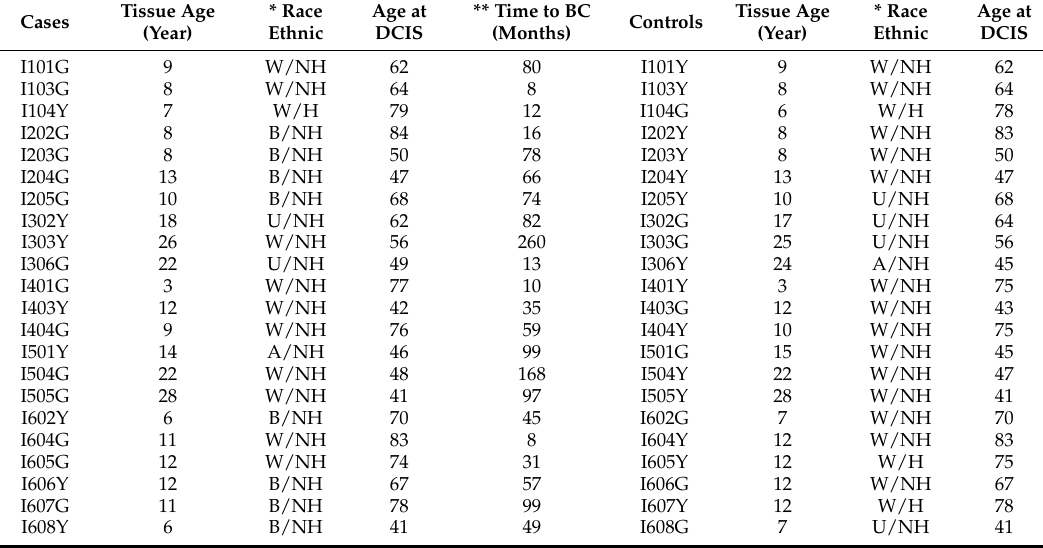
* Race is defined by the following lettering: W for white/caucasian, B for Black/African-American, A for Asian, U for unknown, Ethnic background is defined by H for Hispanic/Latino or NH for Non-Hispanic/Latino. ** Time between diagnosis of DCIS and Breast cancer (BC) in